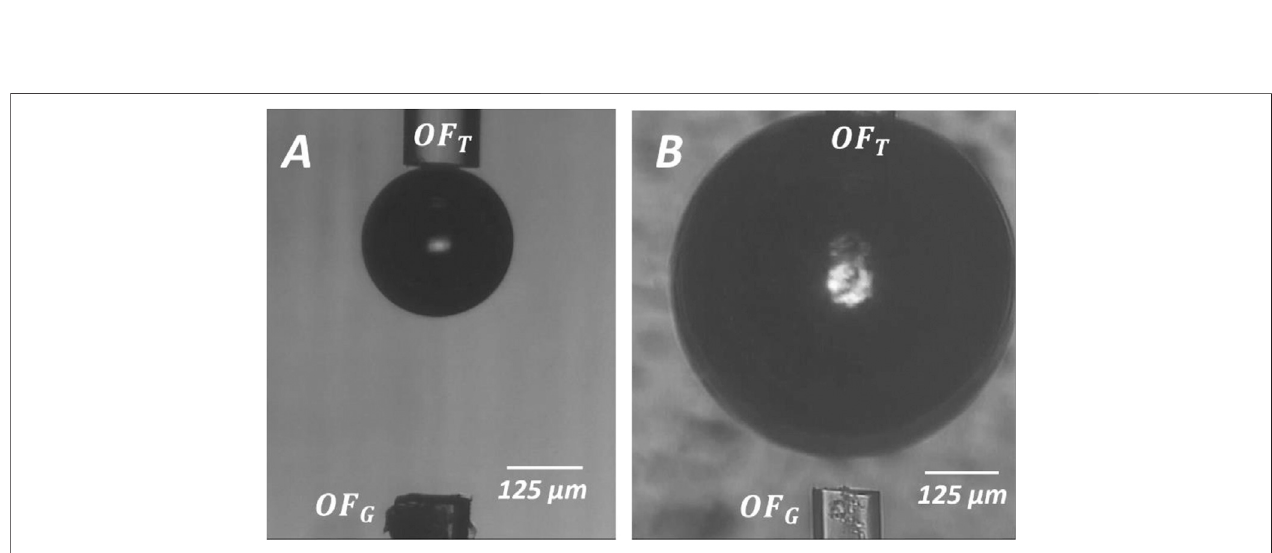
FIGURE 4 | Trapping of microbubbles with apower of 2 mW. Large bubbles touch the optical fi ber OF T (A) R ∼ 130 μ m, and (B) R ∼ 333 µm. For microbubbles of radius R ≥ 130 µm trapping becomes unstable and manipulation is not possible.